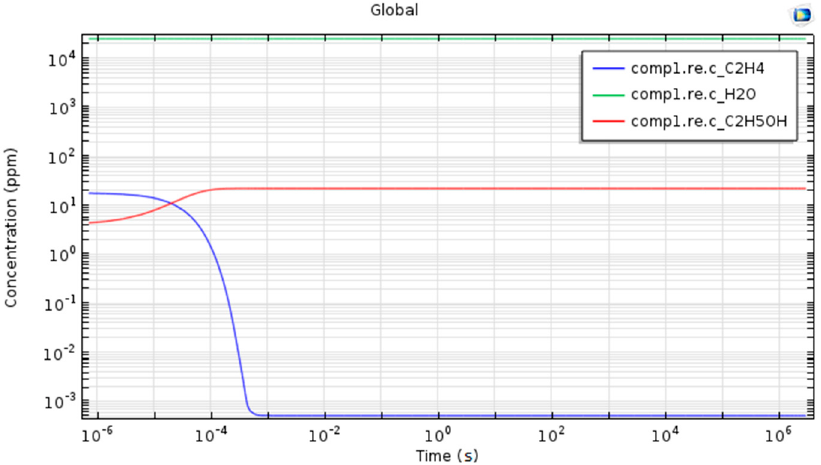
Figure 7. Time dependence of ethylene, ethanol and water vapor concentrations plotted on a logarithmic scale over a period of 35 days.